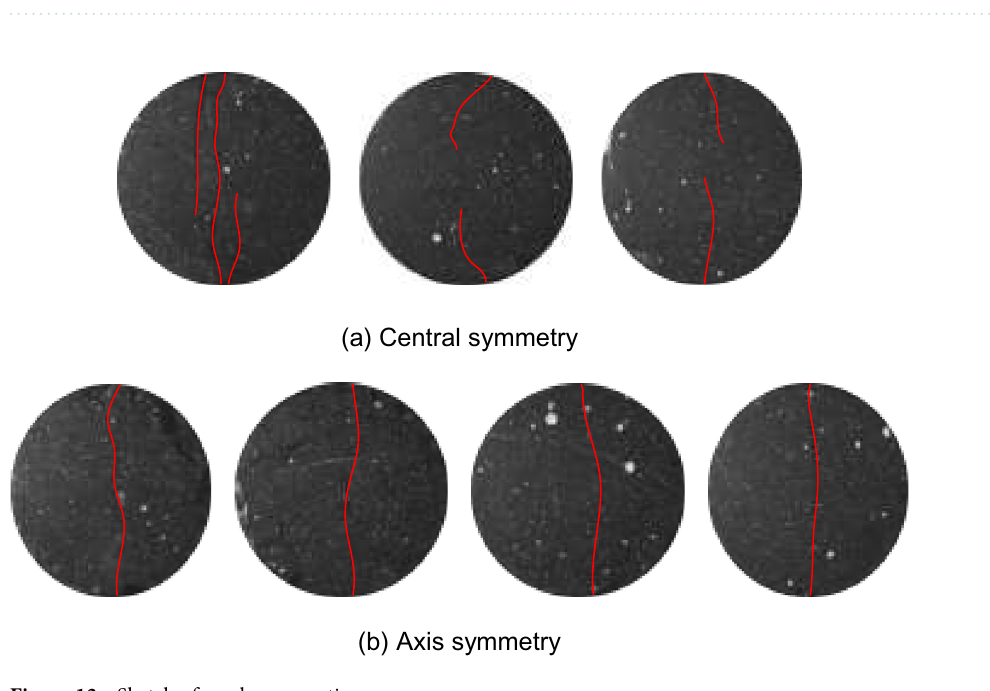
Figure 13. Sketch of crack